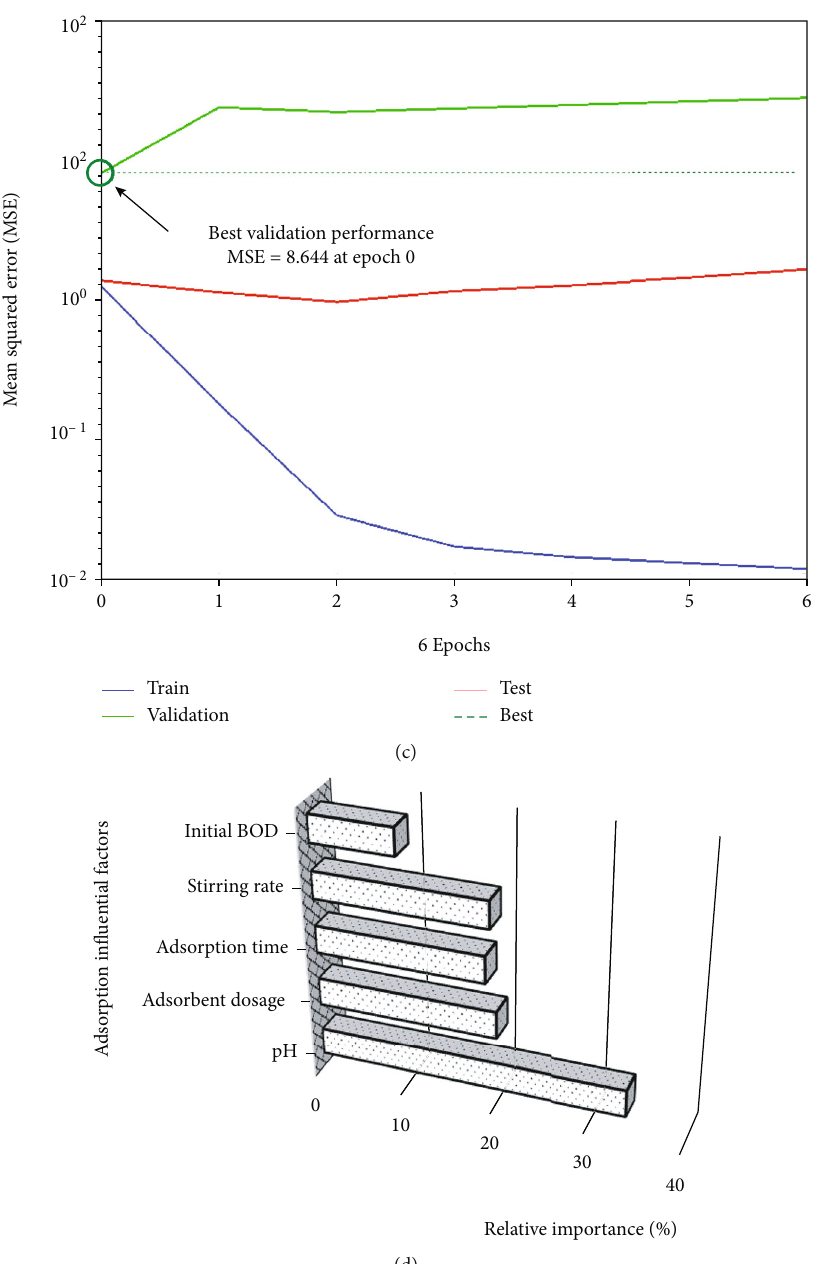
Figure 5: Performance of ANN model for predicting BOD removal e ffi ciency: (a) regression plot, (b) validation checks, (c) best validation, and (d) relative importance. The number of data points in the training, cross-validating, and testing sets had 70%, 15%, and 15% proportions,